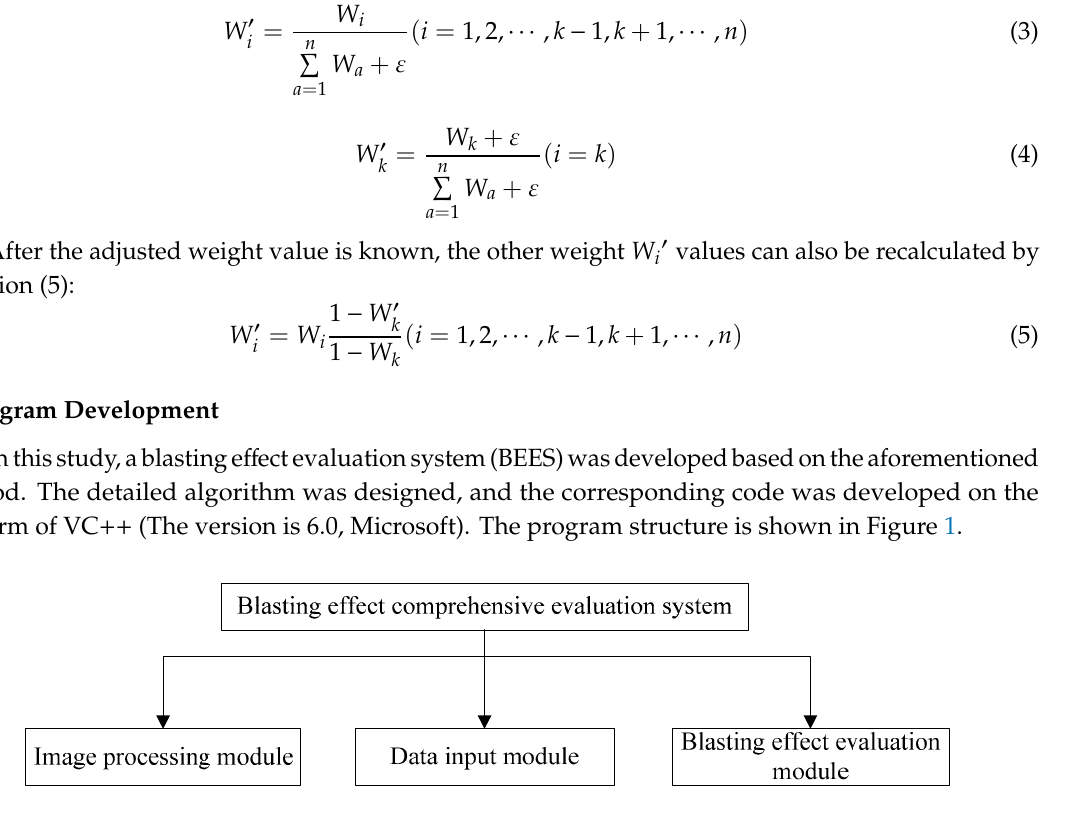
Figure 1. Program structure of BEES.